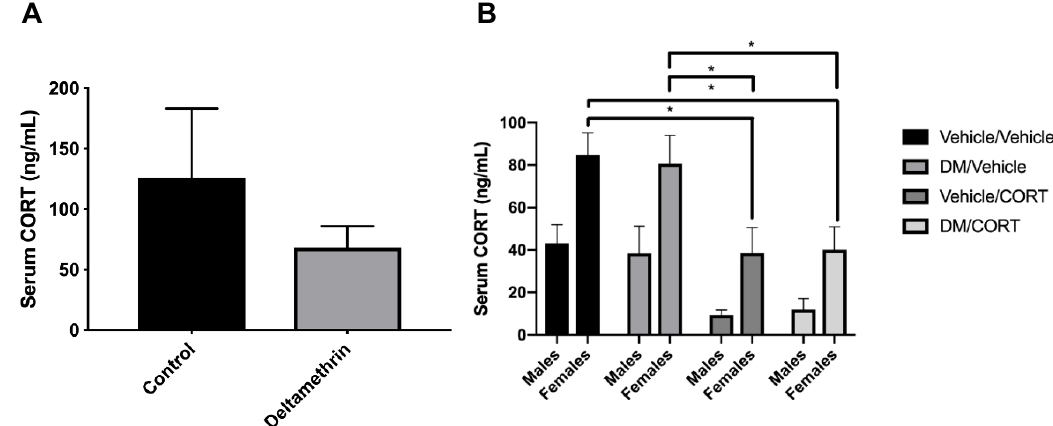
Figure 2. Exposure to oral CORT decreased endogenous CORT production independent of deltamethrin exposure in male and female offspring, and there was no significant difference in endogenous CORT production of female dams exposed to deltamethrin during gestation. We tested endogenous CORT levels via an ELISA assay to assess ( A ) whether deltamethrin exposure affects circulating corticosterone in the pregnant dams, which could subsequently affect in utero CORT levels observed by their offspring; and ( B ) whether CORT exposure affects circulating CORT in male and female offspring exposed to deltamethrin, oral CORT, or both. Exposure group differences were assessed via a two ‐ tailed t ‐ test for the exposed versus unexposed female dams (A) and via one ‐ way ANOVA with Tukey’s post ‐ hoc test, stratified by sex, for the male and female offspring (B). N = 7–8 in (A), N = 5–7 in (B), and error bars represent SEM. * p < 0.05.